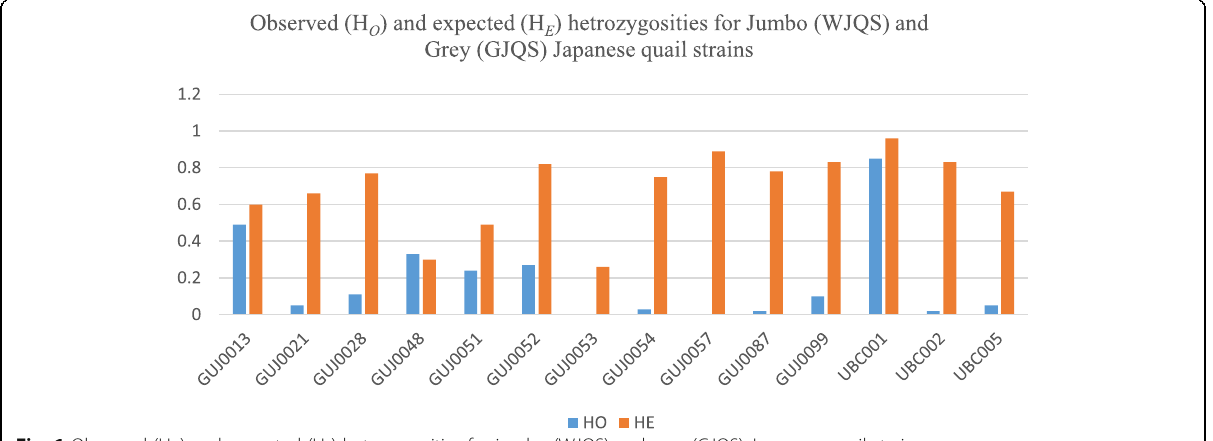
Fig. 1 Observed (H O ) and expected (H E ) hetrozygosities for jumbo (WJQS) and gray (GJQS) Japanese quail strains